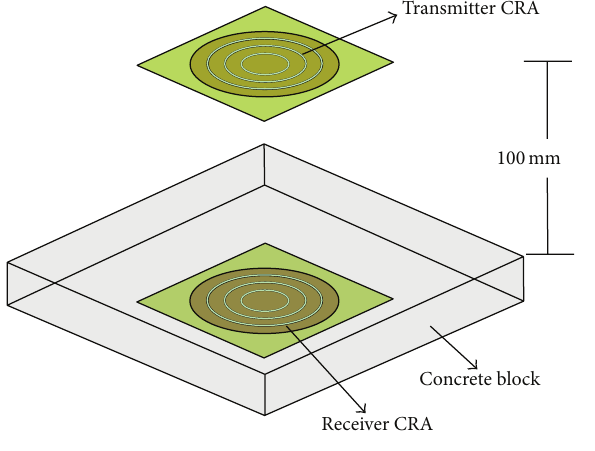
Figure 24: Case3